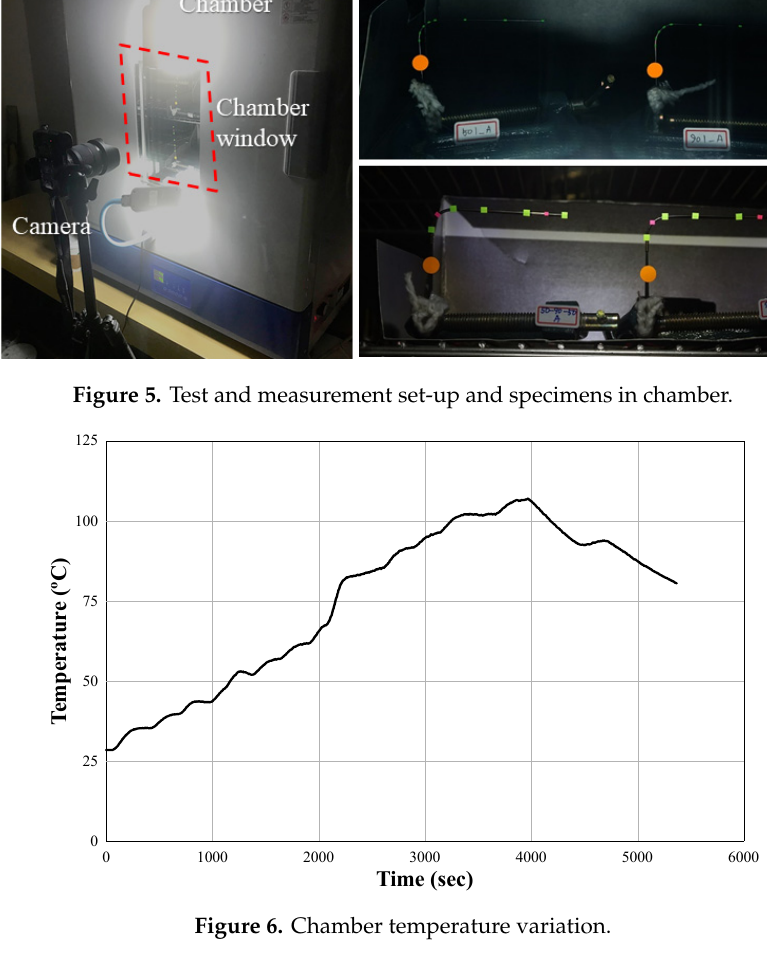
( a ) ( b ) Figure 7. Notations of characteristic value in heating temperature–displacement curves: ( a ) single wire and ( b ) hybrid wire.